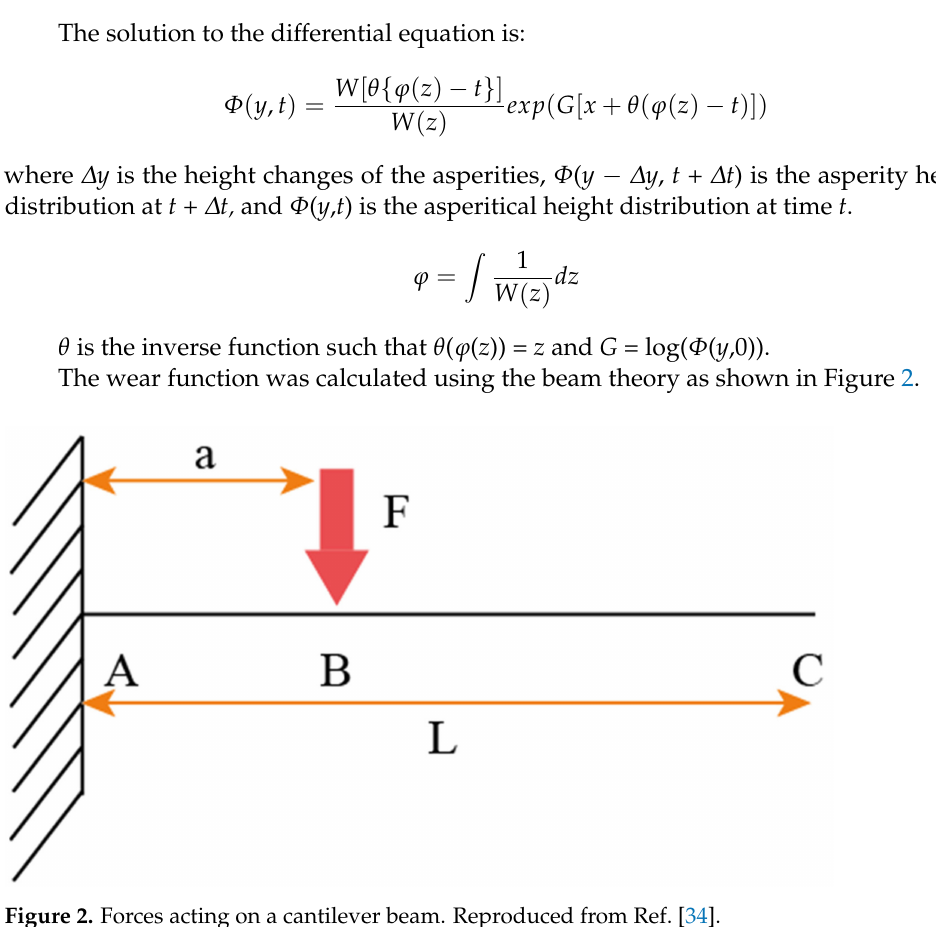
Figure 2. Forces acting on a cantilever beam. Reproduced from Ref.